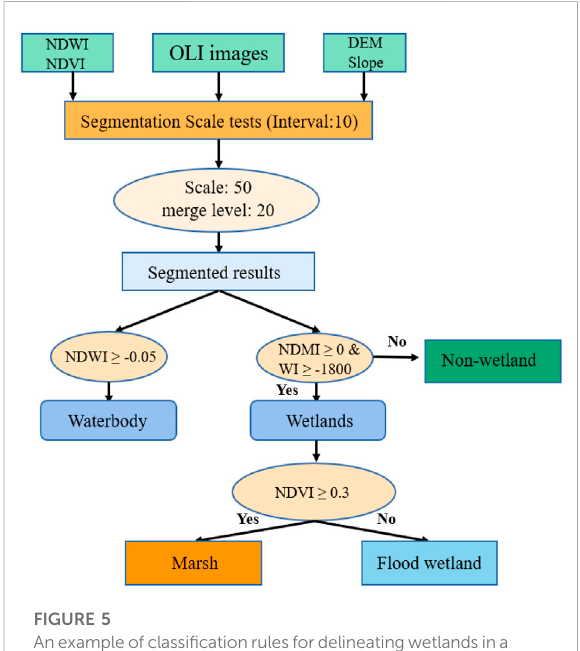
Anexampleofclassi fi cationrulesfordelineatingwetlandsina block of lacustrine plain.